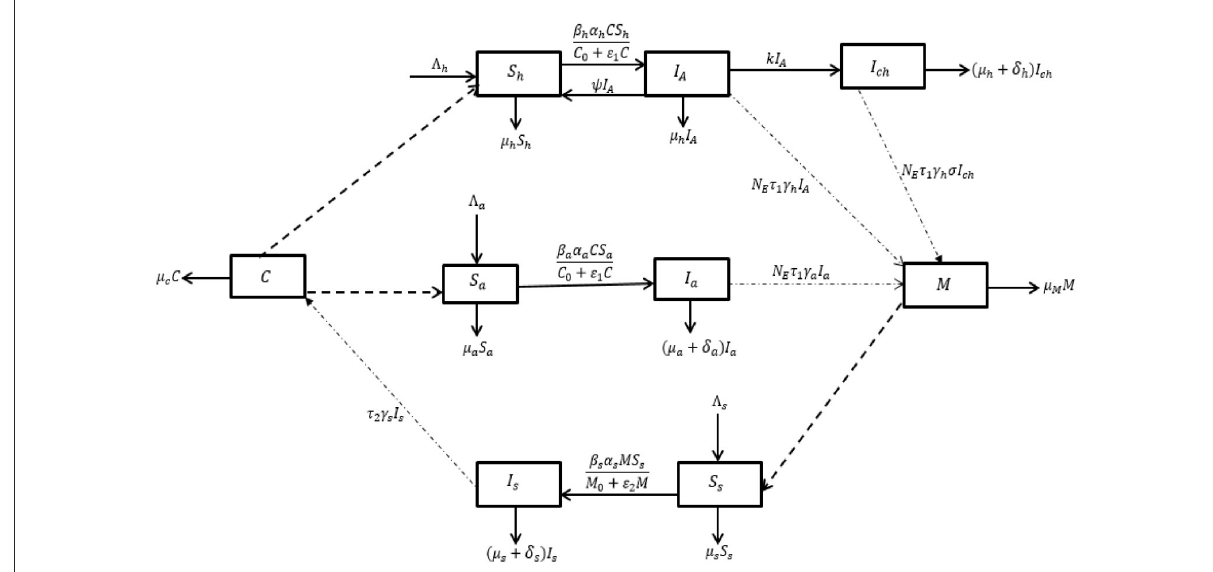
FIGURE1 Flow diagram for the dynamics of Schistosomiasis